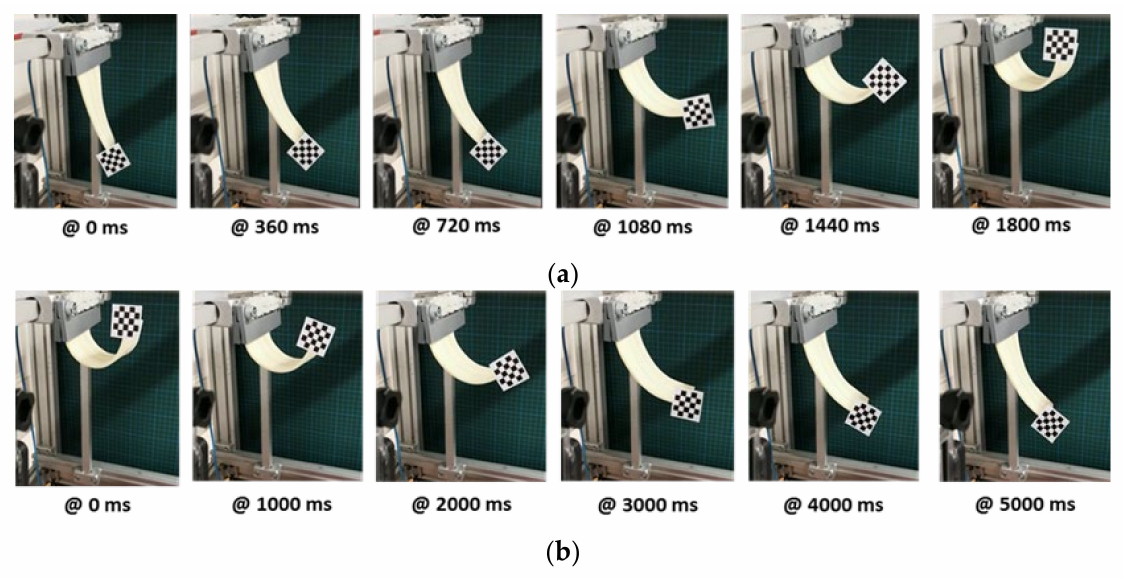
Figure 6. Actuated deformation (bending) of the interactive fiber-elastomer composite with respect to time. ( a ) Voltage-actuated bending and ( b ) re-bending after